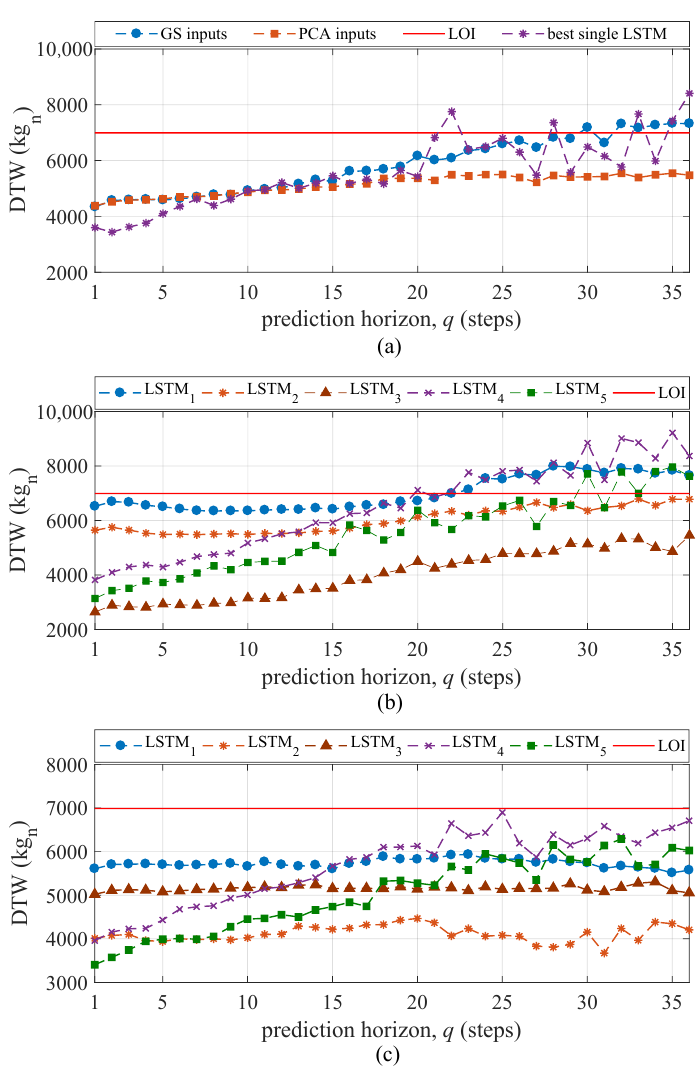
Figure 12. ( a ) Mean DTW over all LSTMs and five tests; ( b ) mean DTW of individual LSTMs over all five tests—“GS inputs”; ( c ) mean DTW of individual LSTMs over all five tests—“PCA